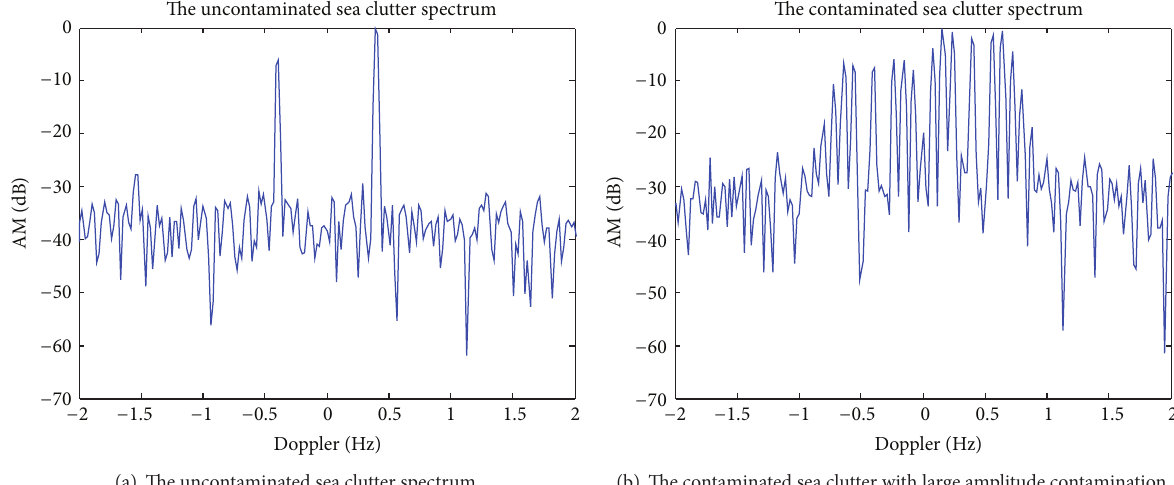
Figure 3: The uncontaminated and the contaminated sea clutter spectra with large amplitude